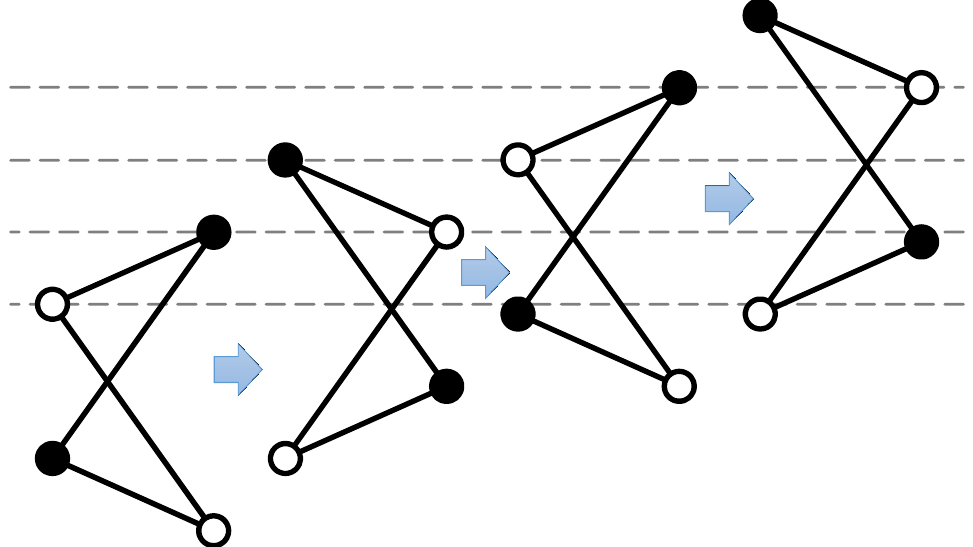
Figure 2. A kinematic model of the lizard-type robot proposed in this study. When the front link is driven during walking, the distance of the supporting leg, depicted in the black circle, does not change. Therefore, our proposed model can drive the supporting legs without